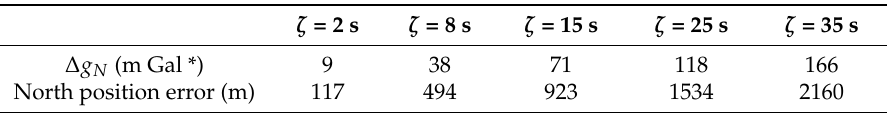
Table 1. The north component of gravity and the amplitude of the north position error corresponding to the gravity vertical